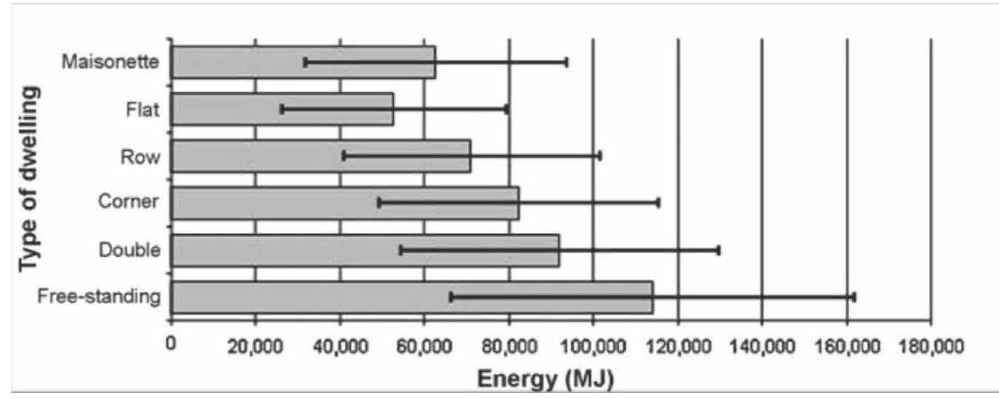
Figure 2. Average and standard deviation for energy use (MJ/Year) per type of dwelling (adapted from [11]).